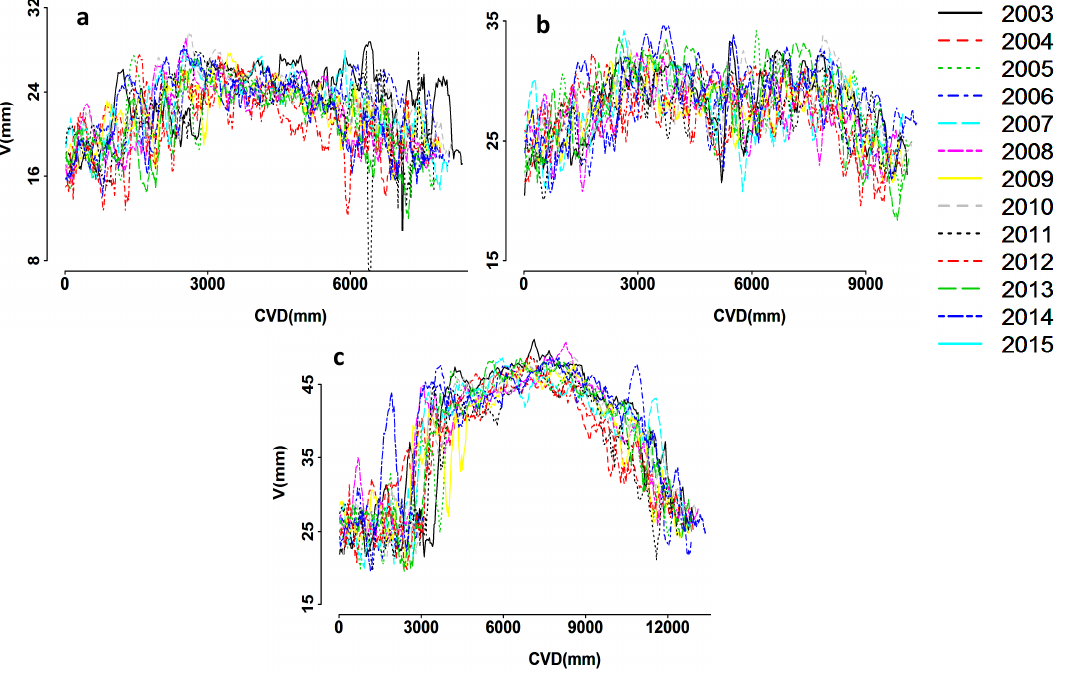
Figure 5. V time series graphs for ET (( a ) site #60), TZ (( b ) #6), and SS (( c ) #85) for 2003–2015. Note differences in scaling of axes.